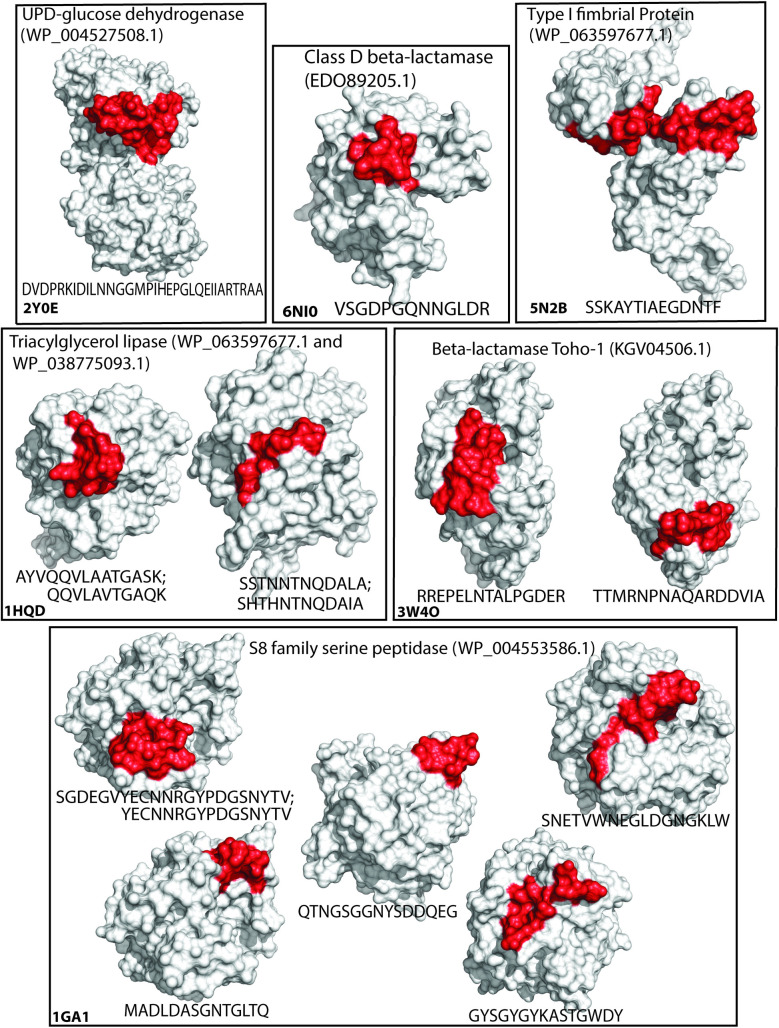
Predicted B-cell epitopes.Graphical representation of B-cell epitopes found in Table 4. Proteins are shown as white surfaces and their respective PDB ID is given in the bottom left corner of each box. The epitope region is highlighted in red and the corresponding homologous sequences found in B. pseudomallei are given in one letter code under each respective structure and separated by semicolon when more than one sequence pointed to the same epitope.